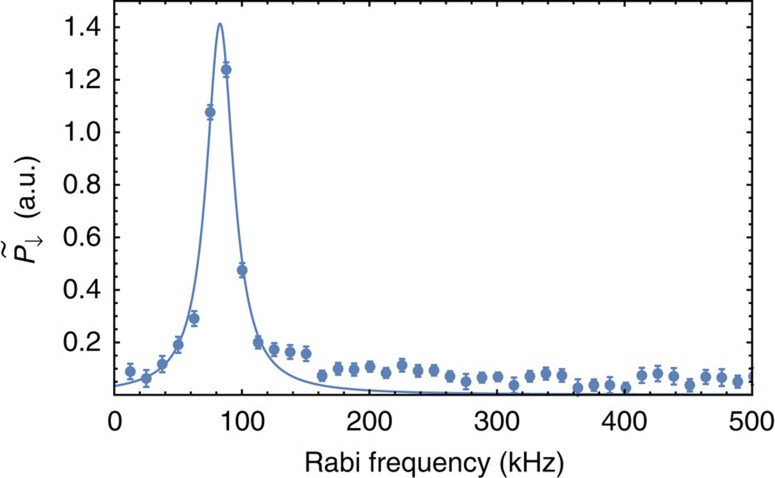
Rabi-frequency spectrum.The data points and curve are obtained as explained in the text. This plot is for the carrier transition (s=0) and a displacement xd≈660 nm (α0≈44).